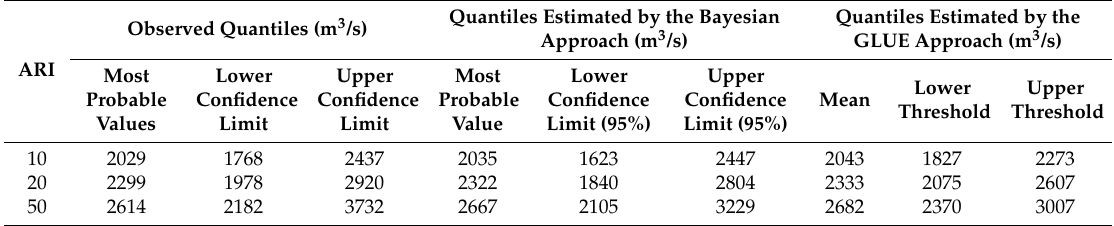
Table 5. Most probable values and confidence limits of flood flows (observed flows versus estimates).